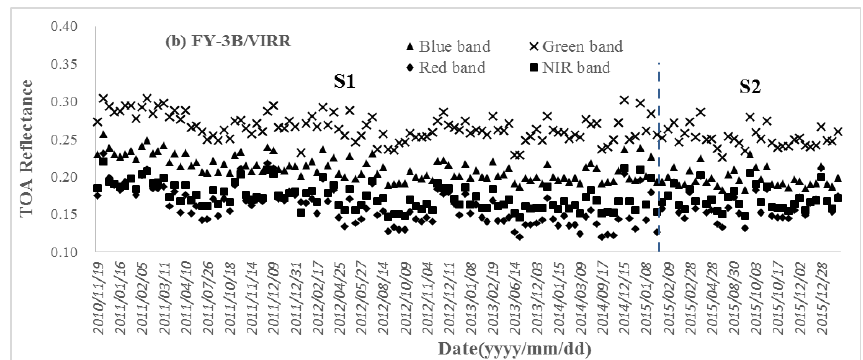
Figure 10. Time series of TOA reflectance of VIRRs in reflective bands: ( a ) FY-3A/VIRR from 2008 to 2015; ( b ) FY-3B/VIRR from 2010 to 2015. The color lines separate different calibration stages. Table 13. The statistics from the time series of the TOA reflectance of